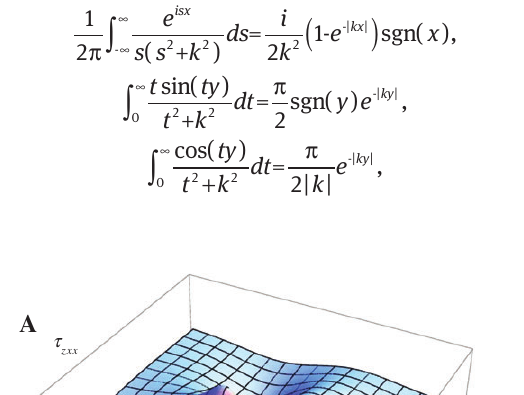
Figure 4 Double stresses of a straight screw dislocation in an FGM within the second strain gradient when a = 0.5 and c stresses are given in units of μ